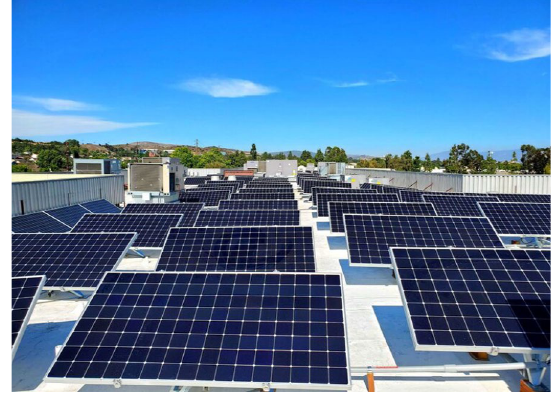
Fig. 7 PV system install on a Commercial Office Building (https:// www. point loadp ower. com/ artic les/ 10- common- quest ions-